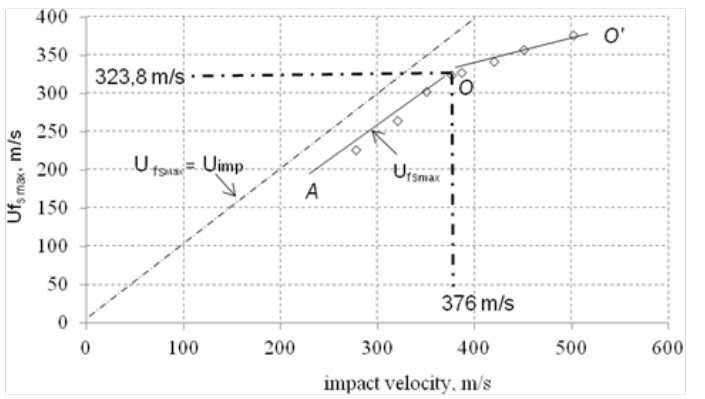
Figure 3. Dependence of the maximum free surface velocity, Ufs max, on the impact velocity for 38CrNi3MoV steel. Dotted line at 450 corresponds to equality of the free surface velocity to impact velocity under symmetrical collision. Transition to structure-unstable state occurs at the impact velocity of 376